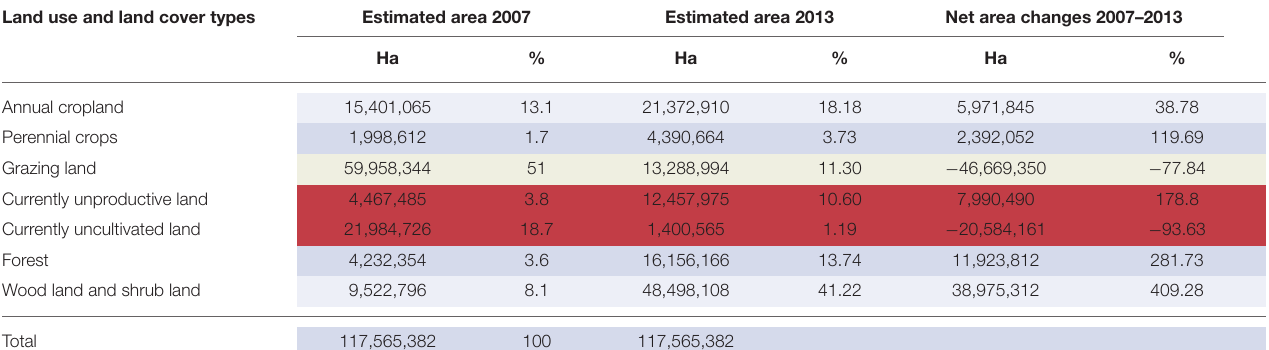
TABLE 2 | Estimated area and net area change of land use land cover types (Simane Personal Communication, 2019).